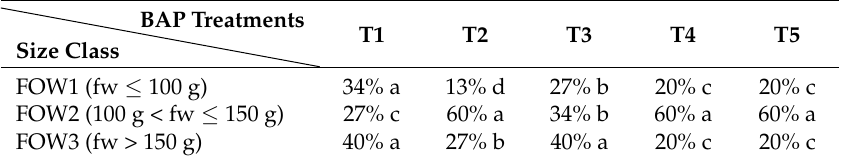
Table 4. Percentage distribution of field offshoot weight (FOW) classes from field mother plants according to 6-benzylamino purine (BAP) treatments.